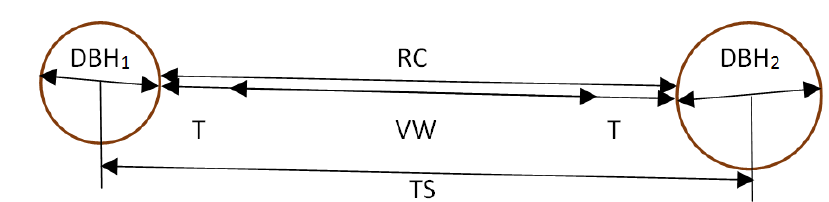
Figure 3. The relation between a particular tree spacing, diameter at breast height ( DBH ), and a riding corridor.